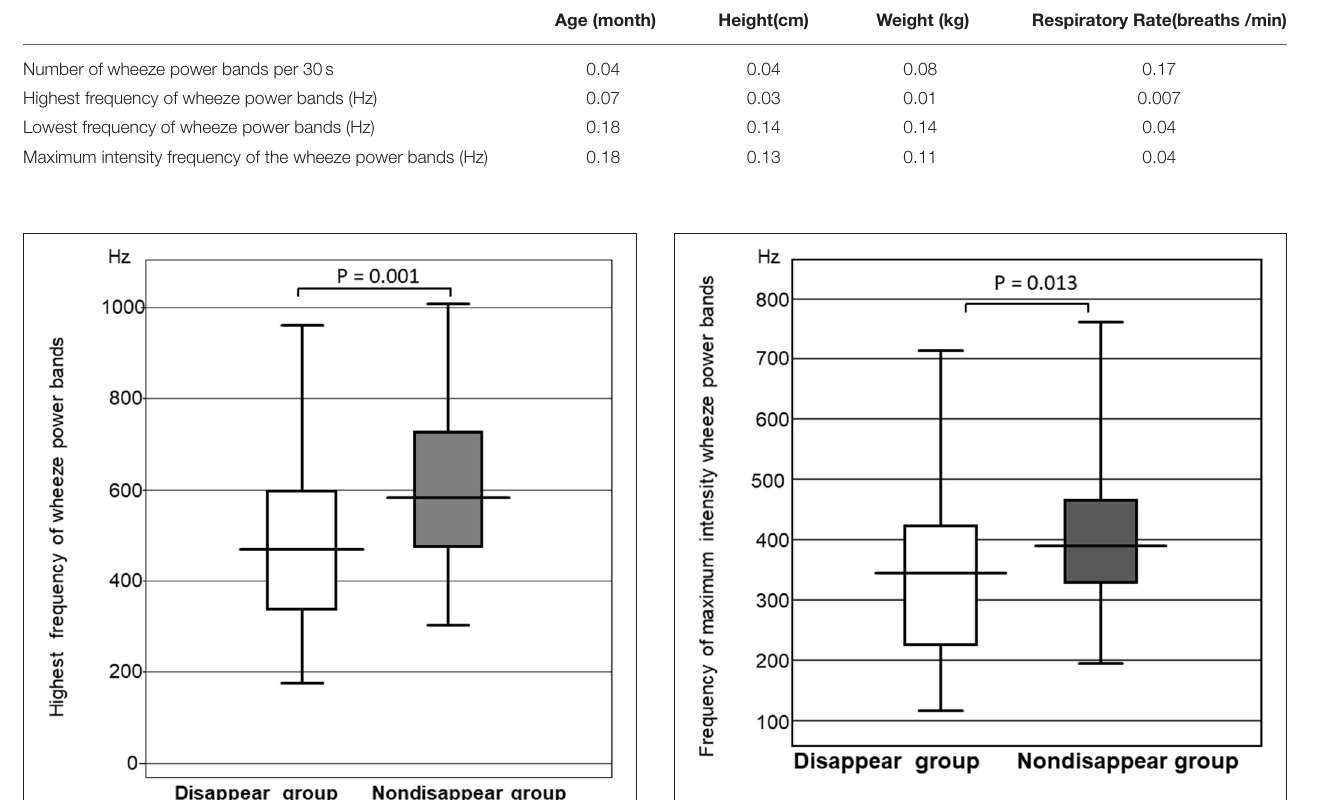
FIGURE 4 | Comparison of the frequency of maximum intensity wheeze power bands between the two groups.